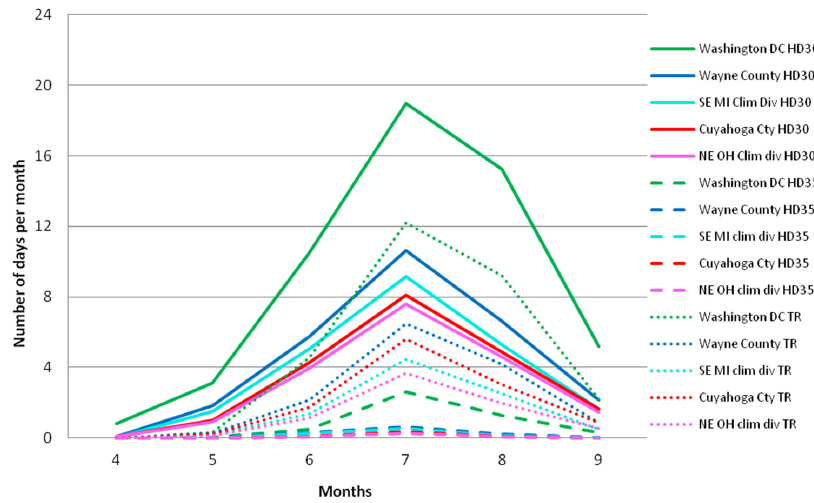
Figure 2. Monthly distribution of the average HD30, HD35 and TR for the period 1971–2000 for all areas, derived using the Maurer02v2 observational dataset.